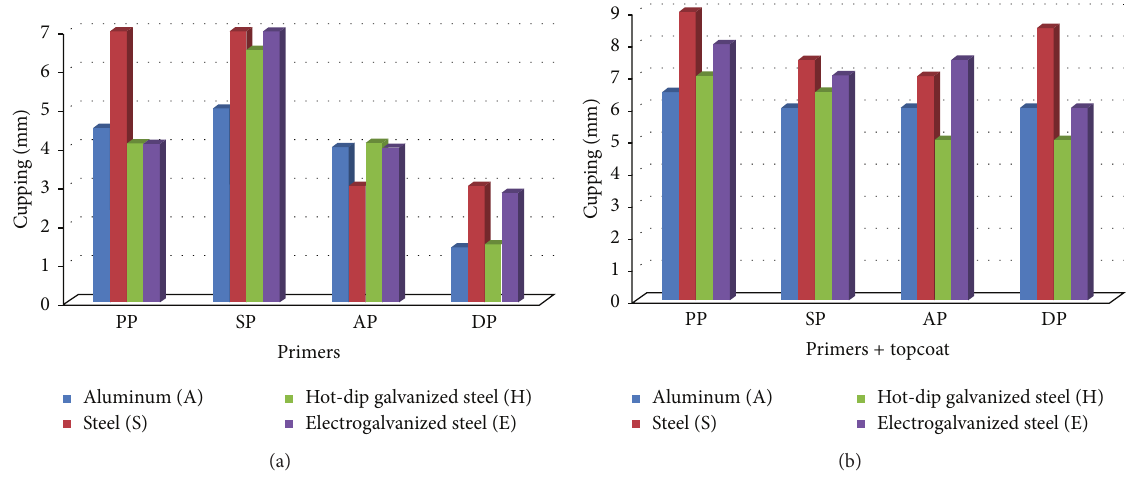
Figure 1: Results of the cupping in an Erichsen cupping tester: (a) primer; (b) primer/topcoat system.